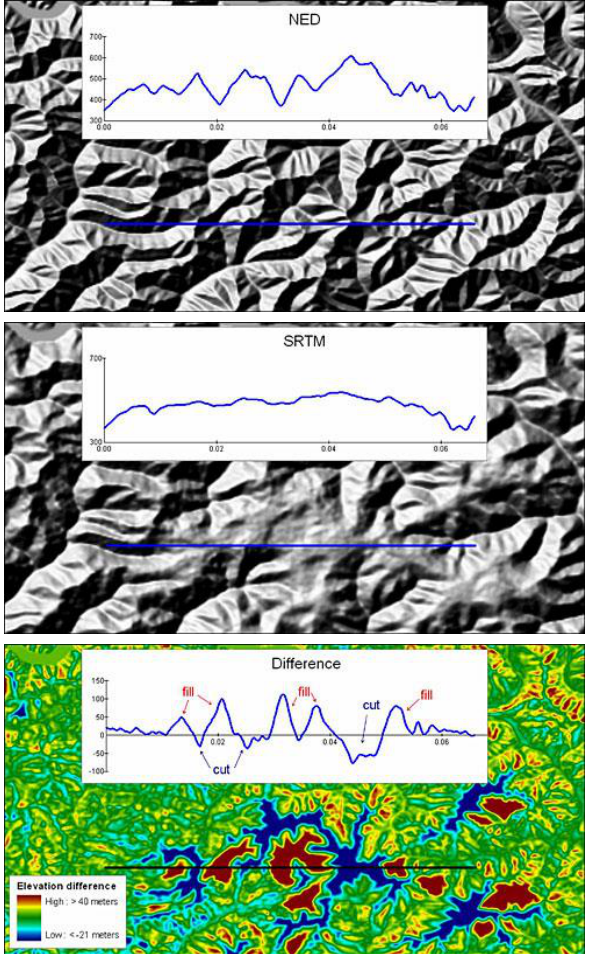
Figure 1. Example of the NED, SRTM, and the derived difference grid for an area in Kentucky in the eastern U.S. The length of the profile is about 5.8